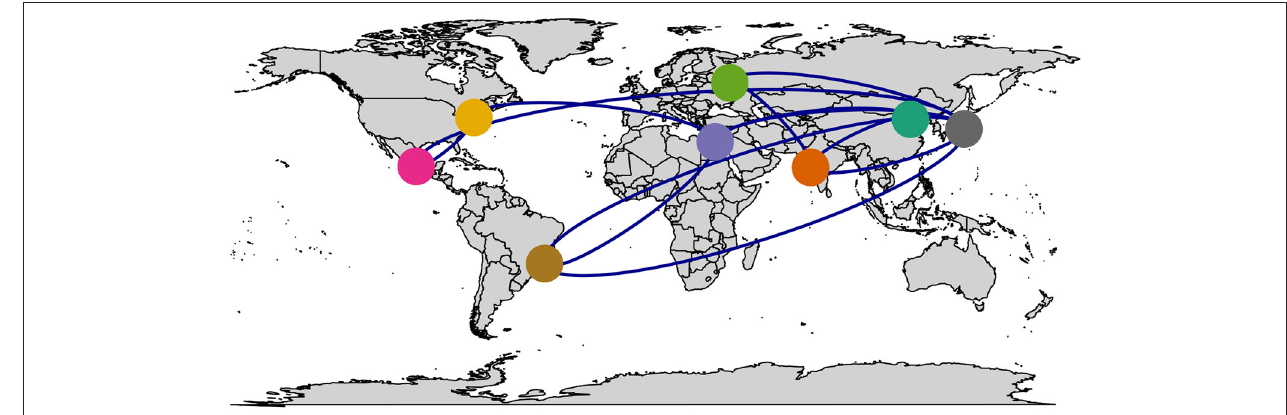
FIGURE 3 | Mapping economic networks with geographic locations by the maps R